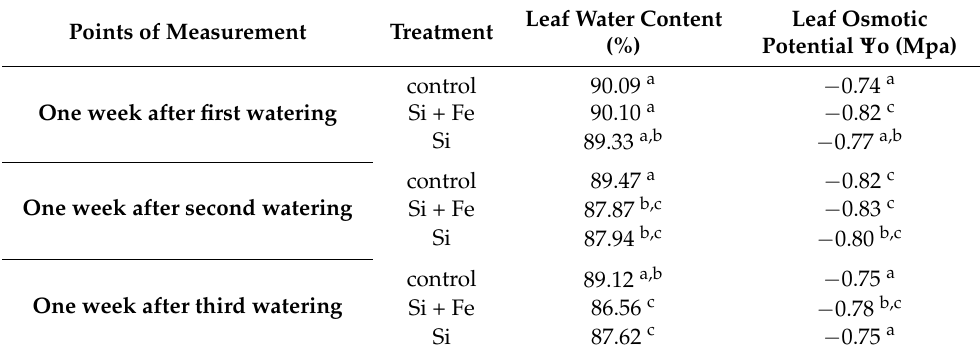
Table 2. Leaf water content and leaf osmotic ( Ψ o) potential in leaves of oilseed rape. Points of